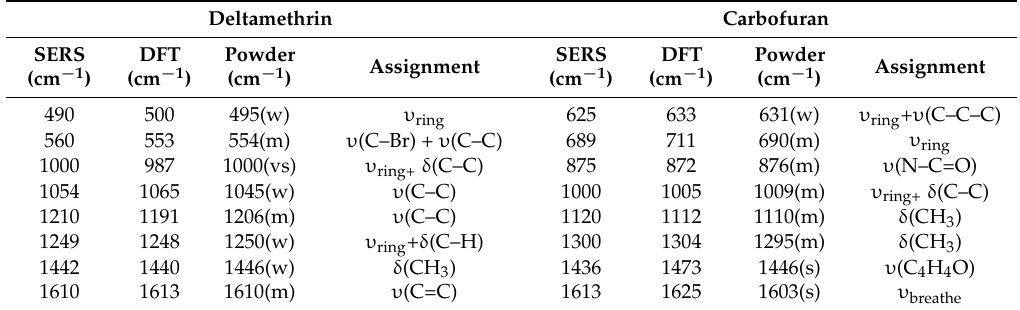
Table 1. Characterization of Raman characteristic peaks of DM and CBF with their vibrational